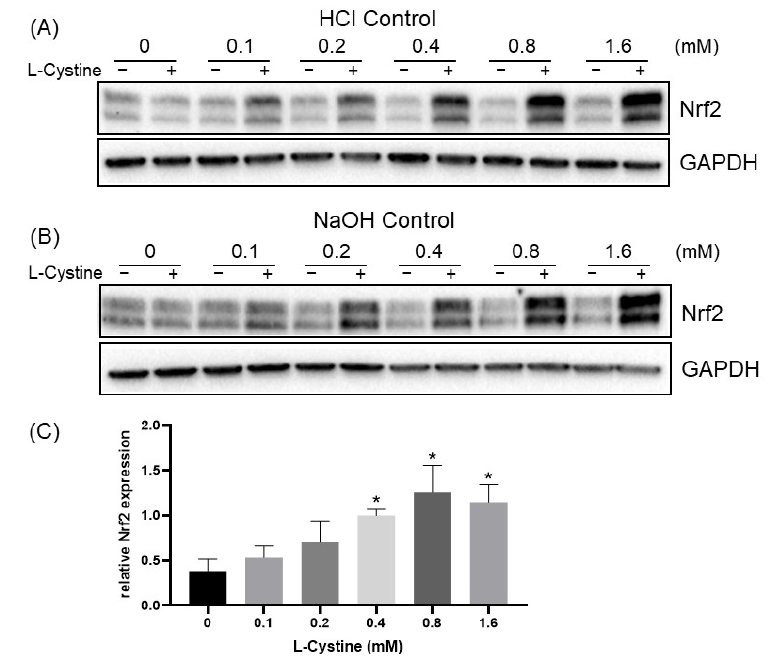
Figure 3. L-Cystine Dose Dependent Induction of Nrf2 Protein. L-Cystine was dissolved in either 500 mM HCl ( A , C ) or 200 mM NaOH ( B ) at a stock concentration of 0.1 M, before adding to HeLa cells on day 3 after subculture at the concentration indicated for 4 h of incubation. An equal volume of solvents was used for controls ( A , B ). Cells were harvested for the Western Blot to detect the levels of Nrf2 protein, using GAPDH as a loading control. The band intensities were quantified by NIH ImageJ to be presented as means ± SD of Nrf2/GAPDH ratio from three independent experiments ( C ). * indicates statistically significant compared to 0 mM L-Cystine as the adjusted p value < 0.05 by one-way ANOVA, corrected by Dunnett’s multiple comparisons test ( C ).